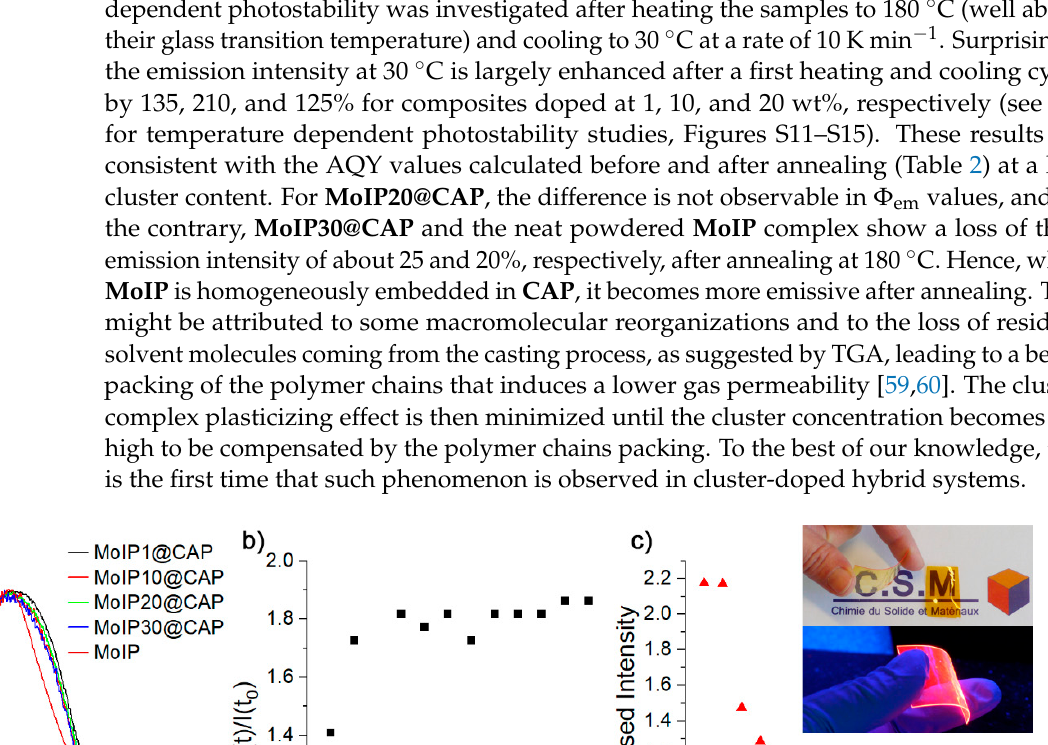
Table 2. Emission properties of the cluster complex and the doped CAP films.